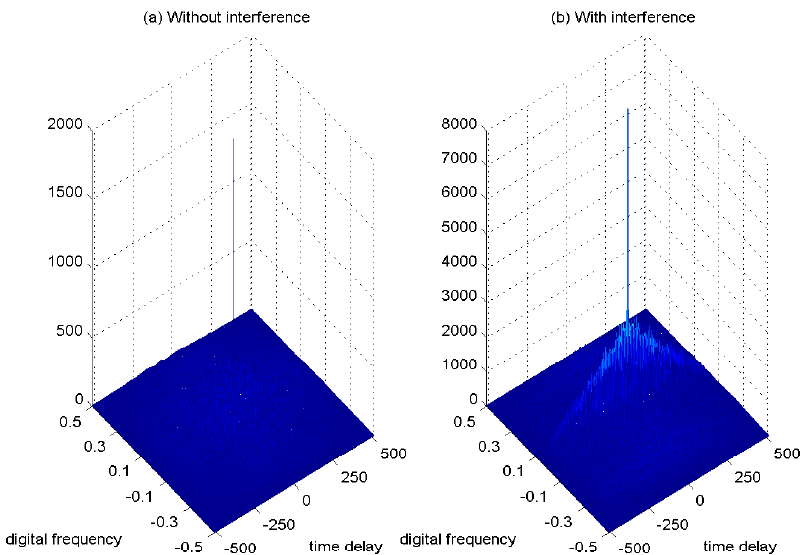
Figure 7. Ambiguity function of the GPS L1 signal. C/N interference; ( b ) with interference, jammer-to-noise ratio (JNR) = − 1